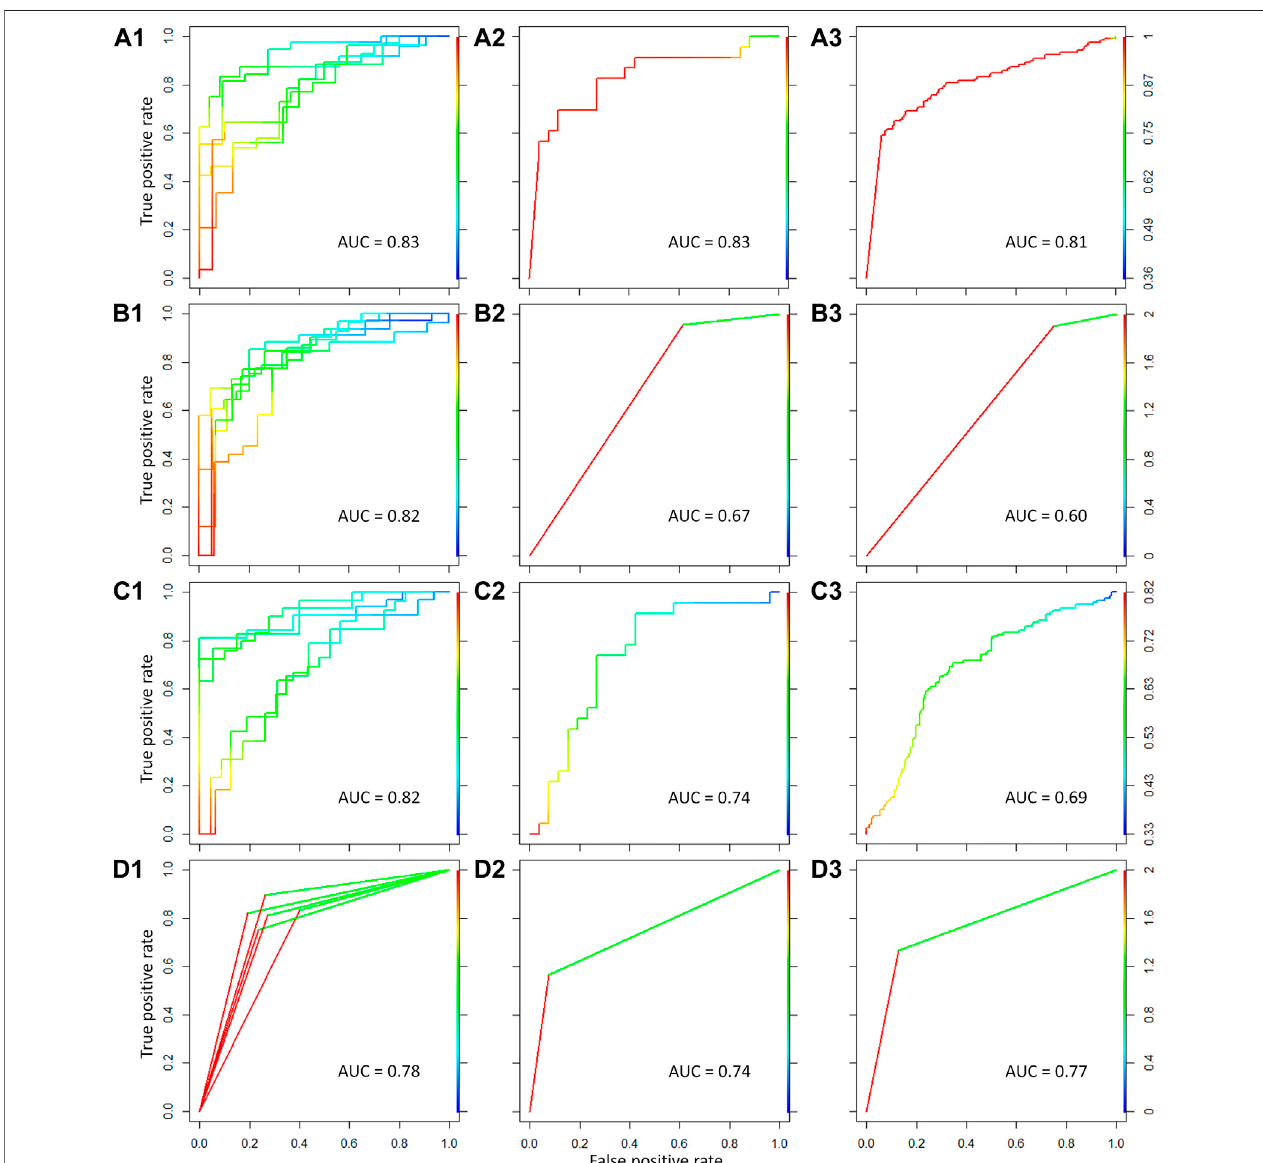
FIGURE 5 | Classi fi cation model constructed for discriminating malignant from benign thyroid nodules using four different machine learning methods. The four methods referred to support vector machine, linear discriminate analysis, partial least squares, and random forest algorithm from top to bottom. The ROC curves and AUCvaluesforthe fi ve-foldcrossvalidationwereshown in (A1 – D1) forthecomprehensivedataset usingthefourmethods. TheROCcurves andAUCvaluesforthe fi rst independent test set were shown in (A2 – D2) . The ROC curves and AUC values for the second independent test set were shown in (A3 – D3) .